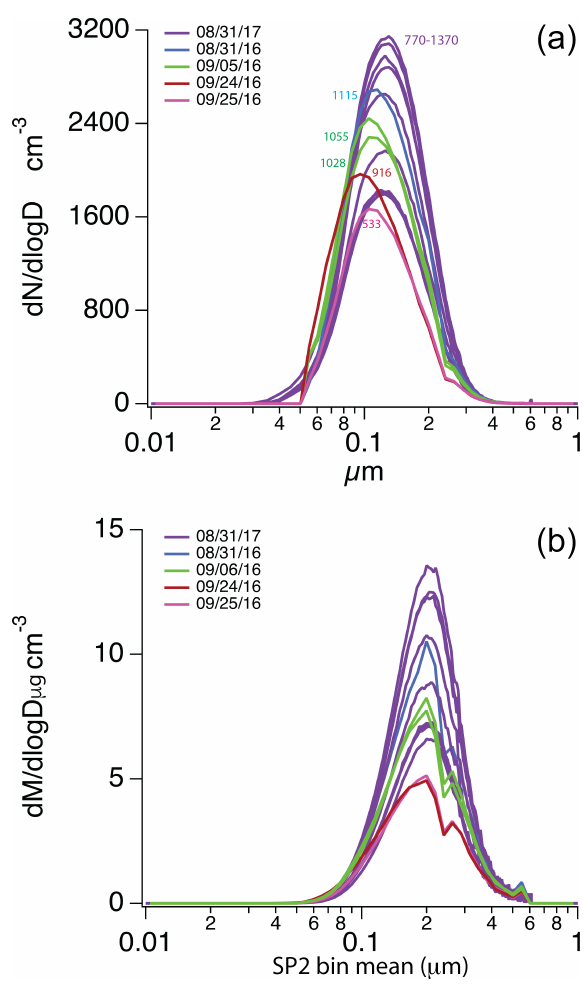
Figure 3. Leg-averaged SP2 size by number (a) and mass (b) dis- tributions for the level legs detailed in Table S2. Total leg-averaged SP2 number concentrations are included in the top plot. The kink at 2.5µm mass mean diameter for the 2016 data is an instrument